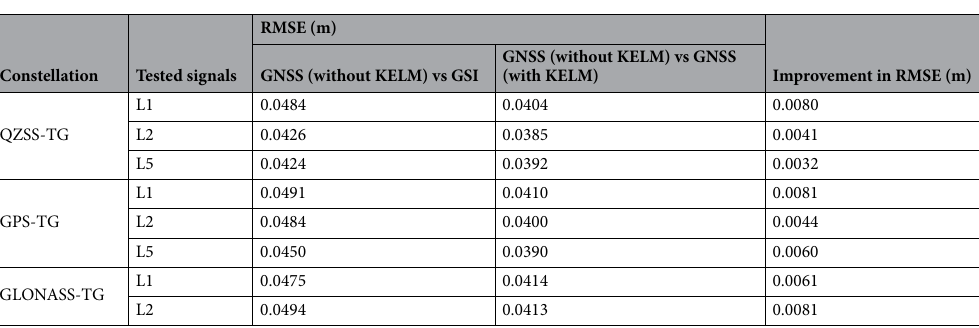
Table 4. GNSS measurement RMSE and their improvement after KELM